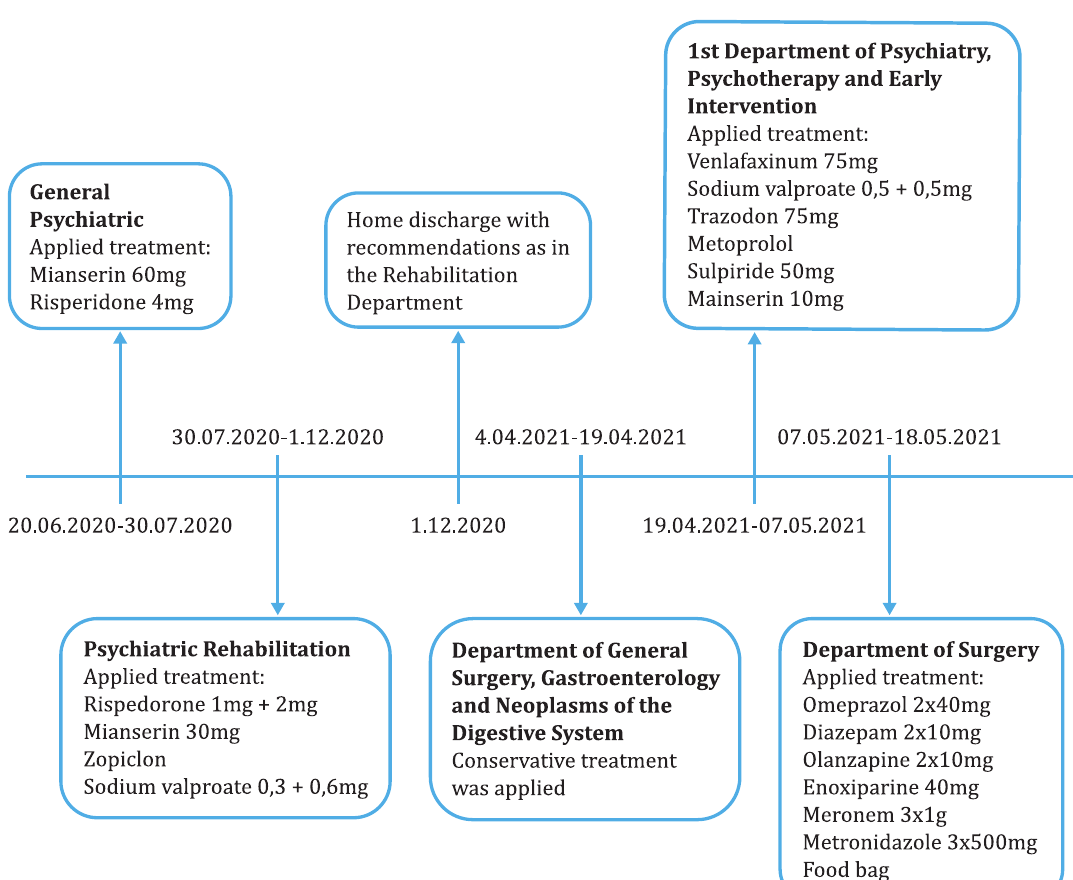
Fig. 1. Time course of subsequent hospitalizations of the patient and the treatment